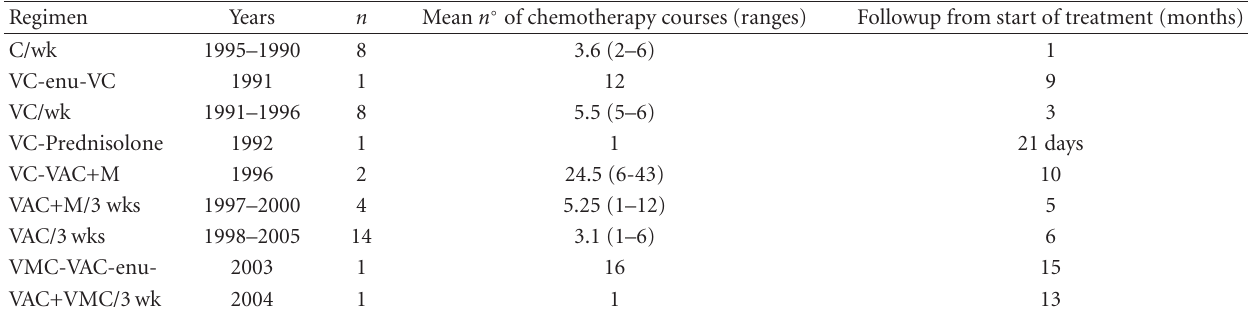
Table 3: Regimens, courses, duration, and followup of chemotherapy for retinoblastoma over time. Regimen